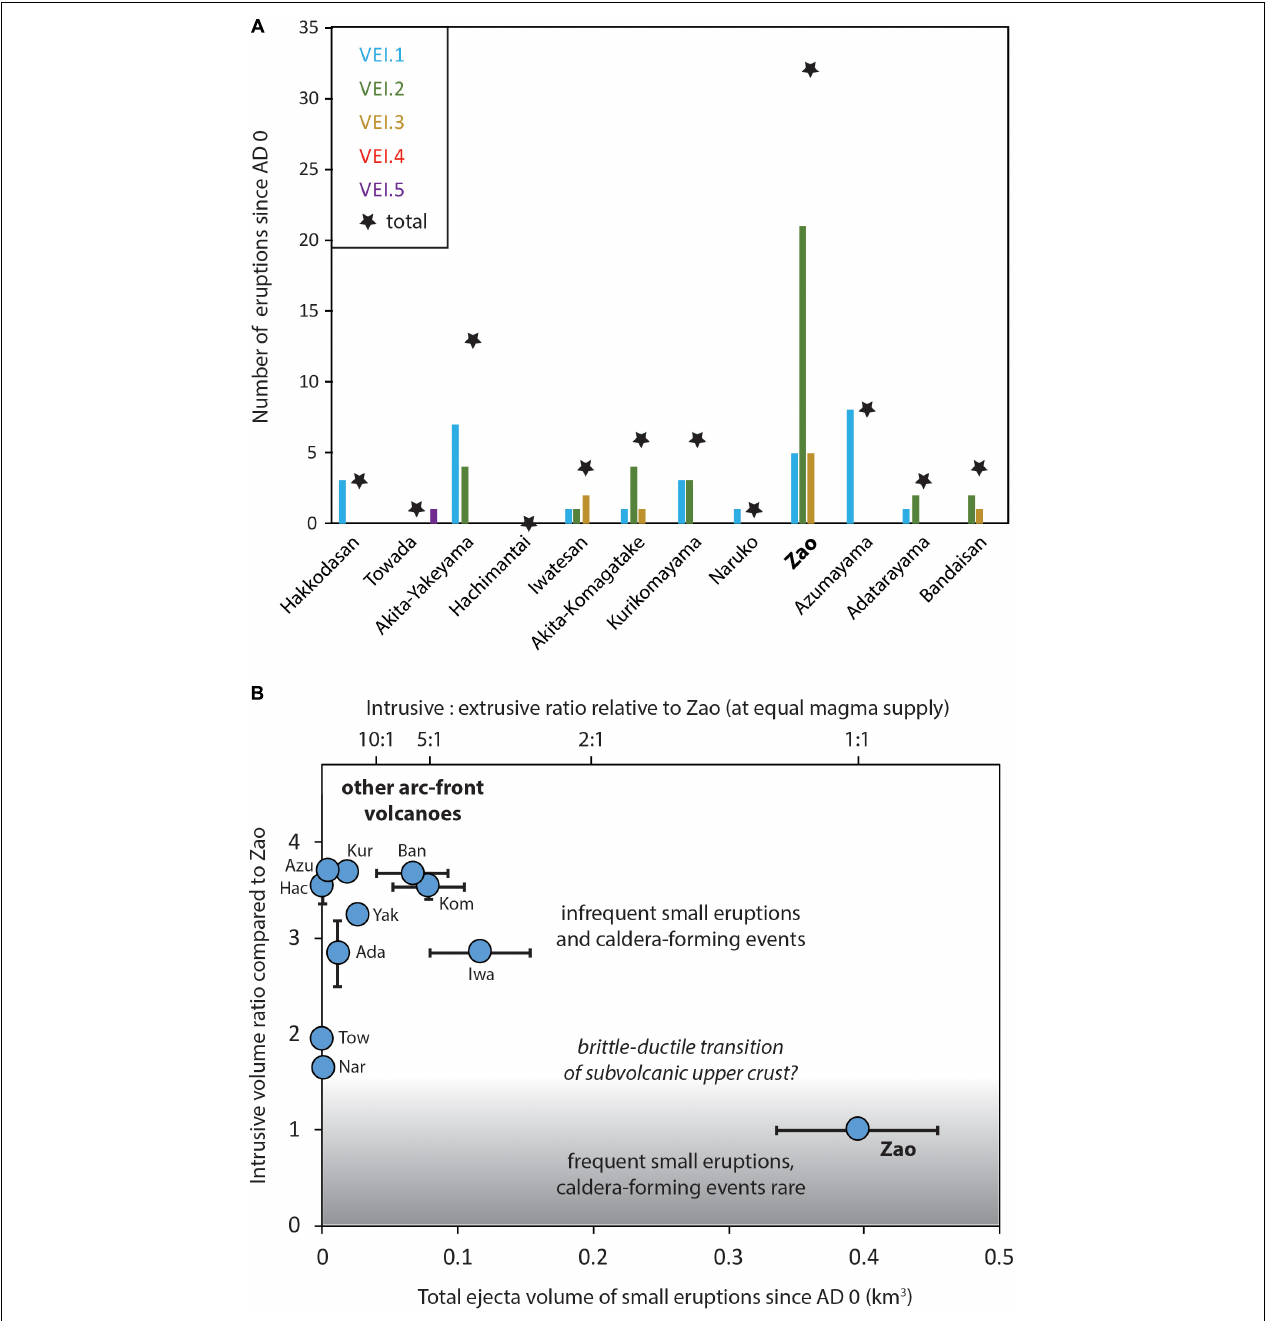
FIGURE 2 | (A) Number of eruptions since AD 0 from each of the arc-front volcanoes listed in Figure 1 , as recorded by the Global Volcanism Program (2013), split by Volcanic Explosivity Index (VEI), and summed for each center (star). Note the large number of eruptions at Zao, dominated by VEI 2 eruptions. (B) Subvolcanic intrusive volume ratios (w.r.t. Zao) versus total ejecta volumes of VEI 1 to VEI 3 eruptions since AD 0. See “Methods” section for details. Uncertainties (1 σ ) in both parameters are indicated when larger than symbol size. Abbreviations: Towada (Tow), Akita-Yakeyama (Yak), Hachimantai (Hac), Iwatesan (Iwa), Akita-Komagatake (Kom), Kurikomayama (Kur), Naruko (Nar), Azumayama (Azu), Adatarayama (Ada), Bandaisan (Ban). Hakkodasan is excluded, as the ambient noise velocity model has too poor constraints in the northernmost and westernmost regions to confidently estimate intrusive volume, due to sparse ray-path coverage in these areas.